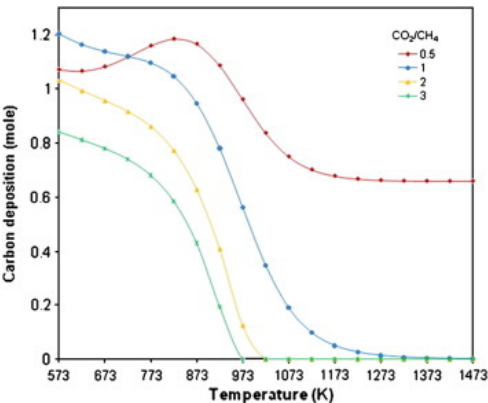
Figure 2. The amount of produced carbon species (mol) during dry reforming of methane (DRM) reaction as a function of temperature and CO 2 /CH 4 ratio at atmospheric pressure for n(CH 4 + CO 2 ) = 2 mol. Reprinted with permission from Ref. [39]. Copyright (2011) Elsevier.